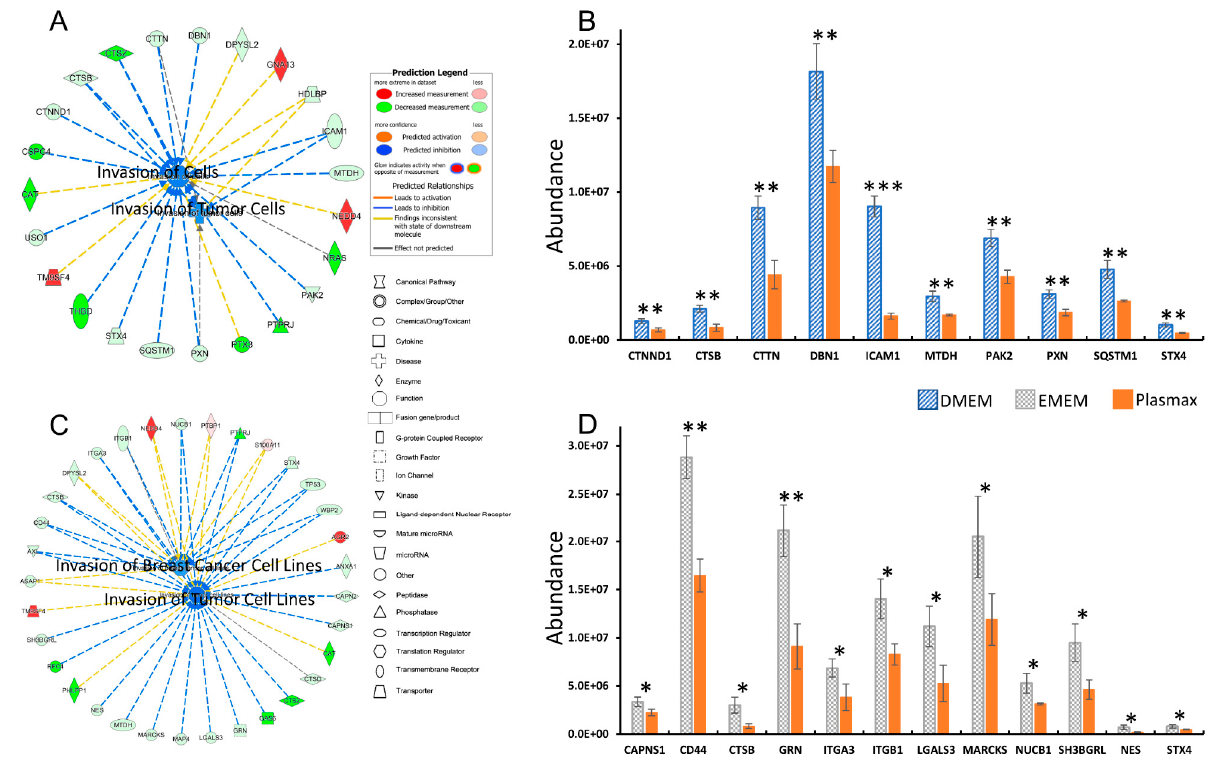
Figure 4. Functional annotation of significant proteins that associate with cell invasion of 231BR cell lines. ( A ) Inhibition of cell invasion of 231BR in Plasmax compared to DMEM; ( B ) Significant down-regulations of invasion-related proteins, Plasmax vs. DMEM. ( C ) Inhibition of cell invasion of 231BR in Plasmax compared to EMEM; ( D ) Significant down-regulations of invasion-related proteins, Plasmax vs. EMEM. * p < 0.05; ** p < 0.01; *** p < 0.001. Color codes and symbols are the same as Figure 2.